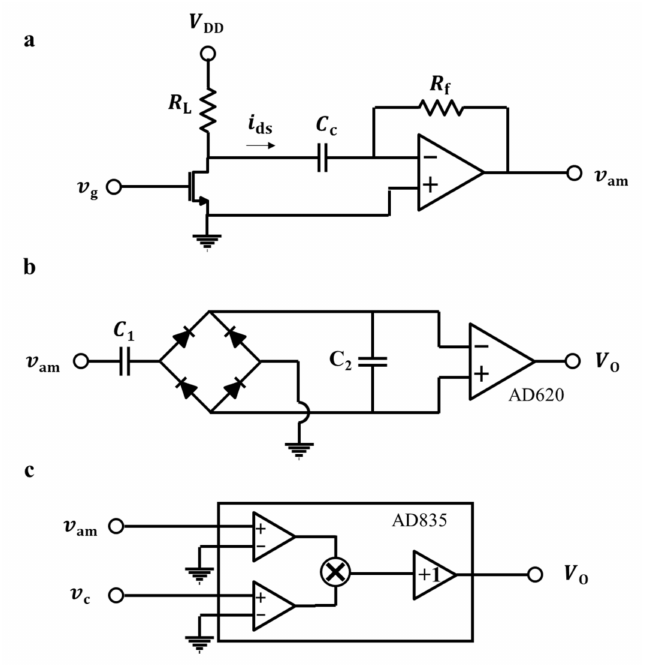
Figure 6. Basicstructuresofthecircuits: ( a ) I - V converter, ( b )envelopdetection, and( c